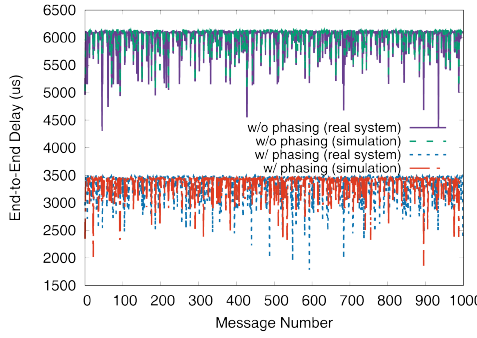
Figure 22. D e 2 e distribution of VC 1 in test set